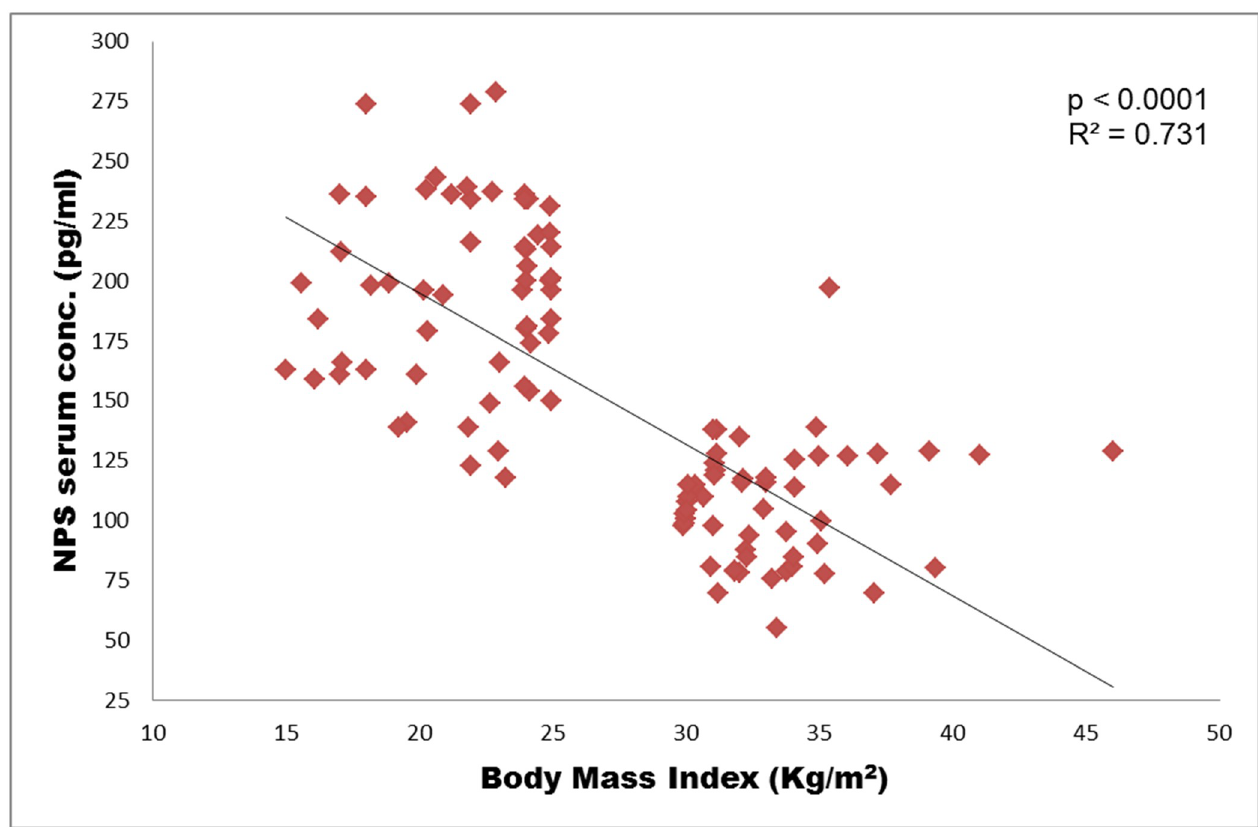
Fig 3. Pearson correlation analysis of NPS serum concentration (pg/ml) versus BMI of all the samples (n = 116). ( r 2 = 0.73, p = 0.0001).